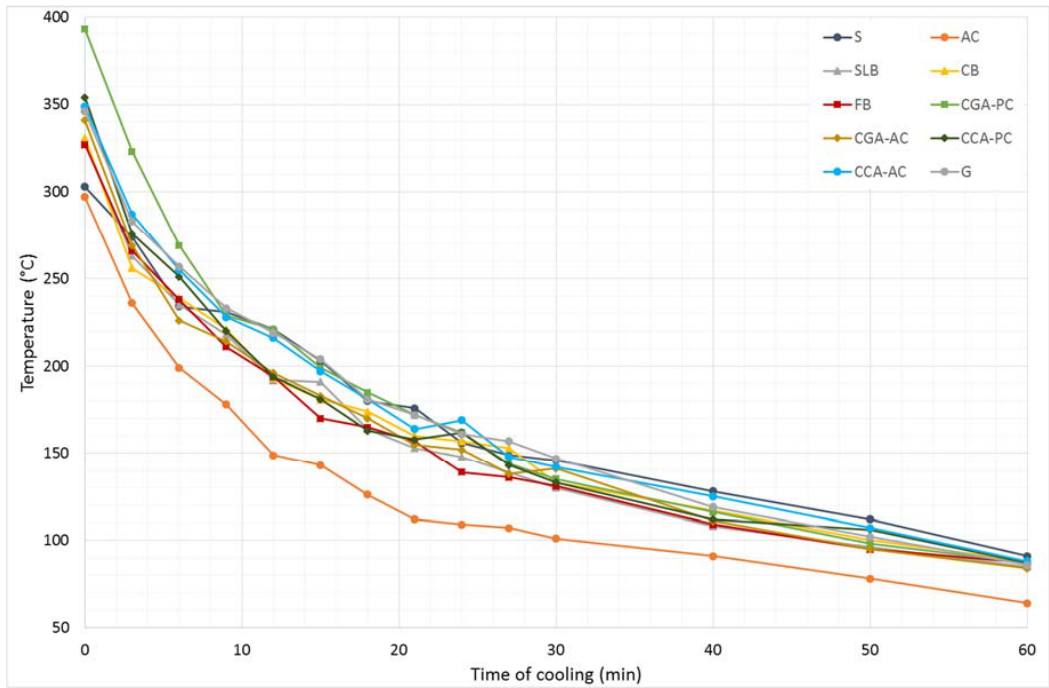
Figure 5. The relation of the temperature drop as a function of the cooling time during the second stage of the experiment; designations are the same as for Figure 4.